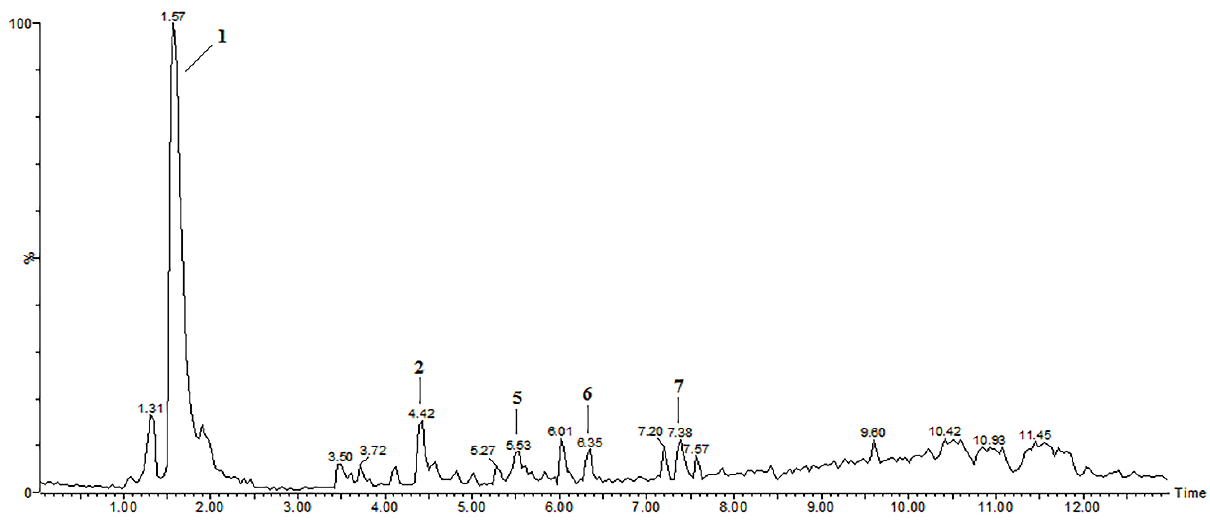
Figure 2. LC-ESI-MS total ion chromatogram (TIC) of the extract of Pfaffia glomerata inflorescences showing peaks 1 , 2 , 5 , 6 and 7 detected in the positive ion